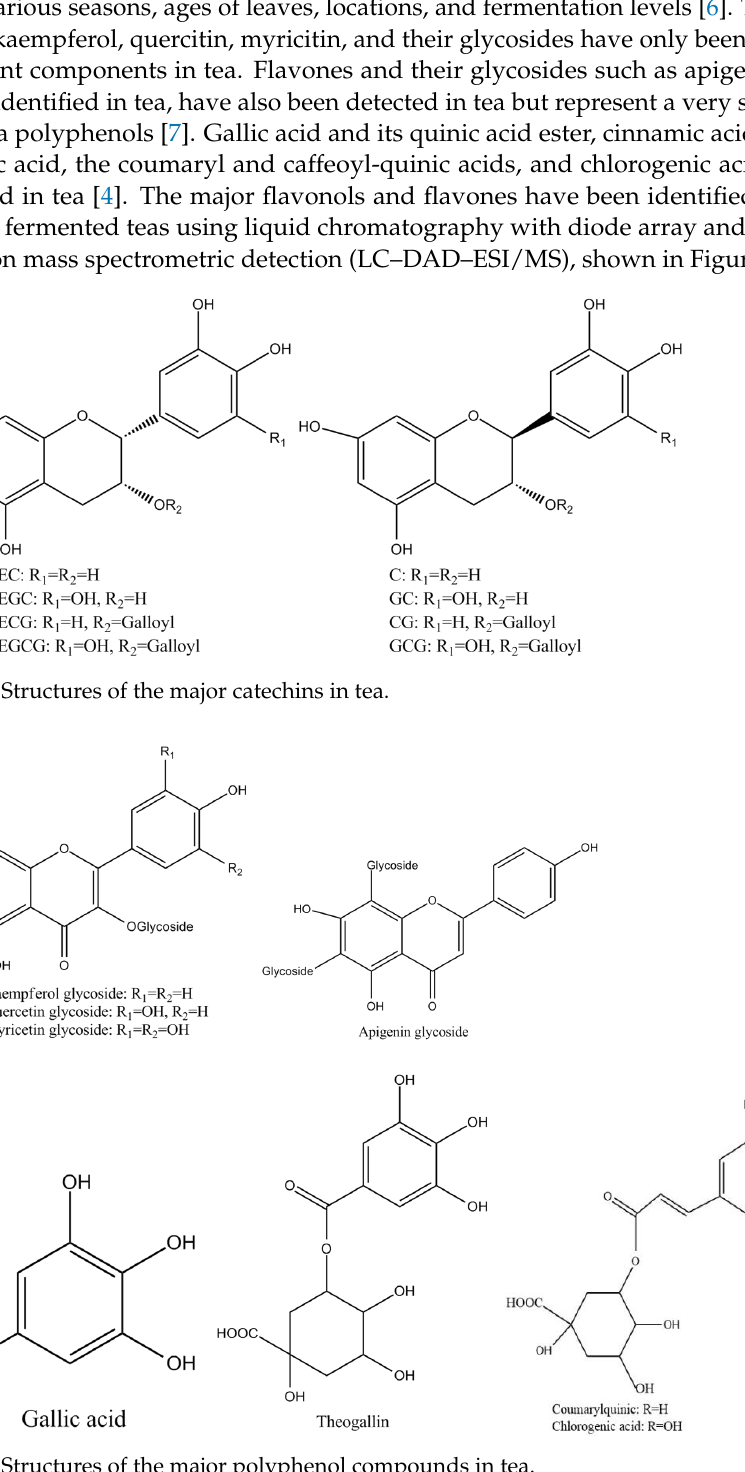
Figure 2. Structures of the major polyphenol compounds in tea.